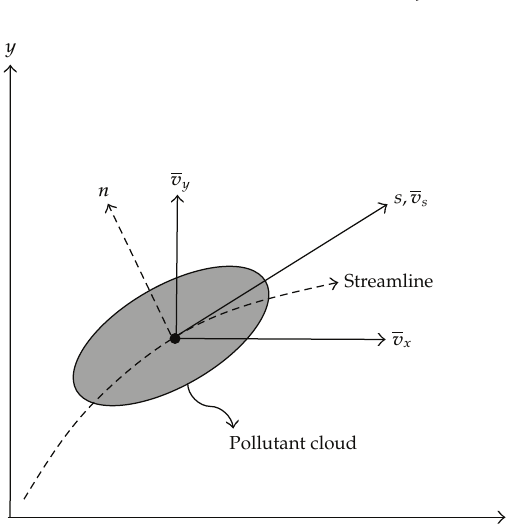
Figure 1: Schematic diagram for CSFD model: x,y : coordinate axes of the Eulerian-Cartesian coordinate system; v x ,v y : components of depth-averaged velocities on the x,y